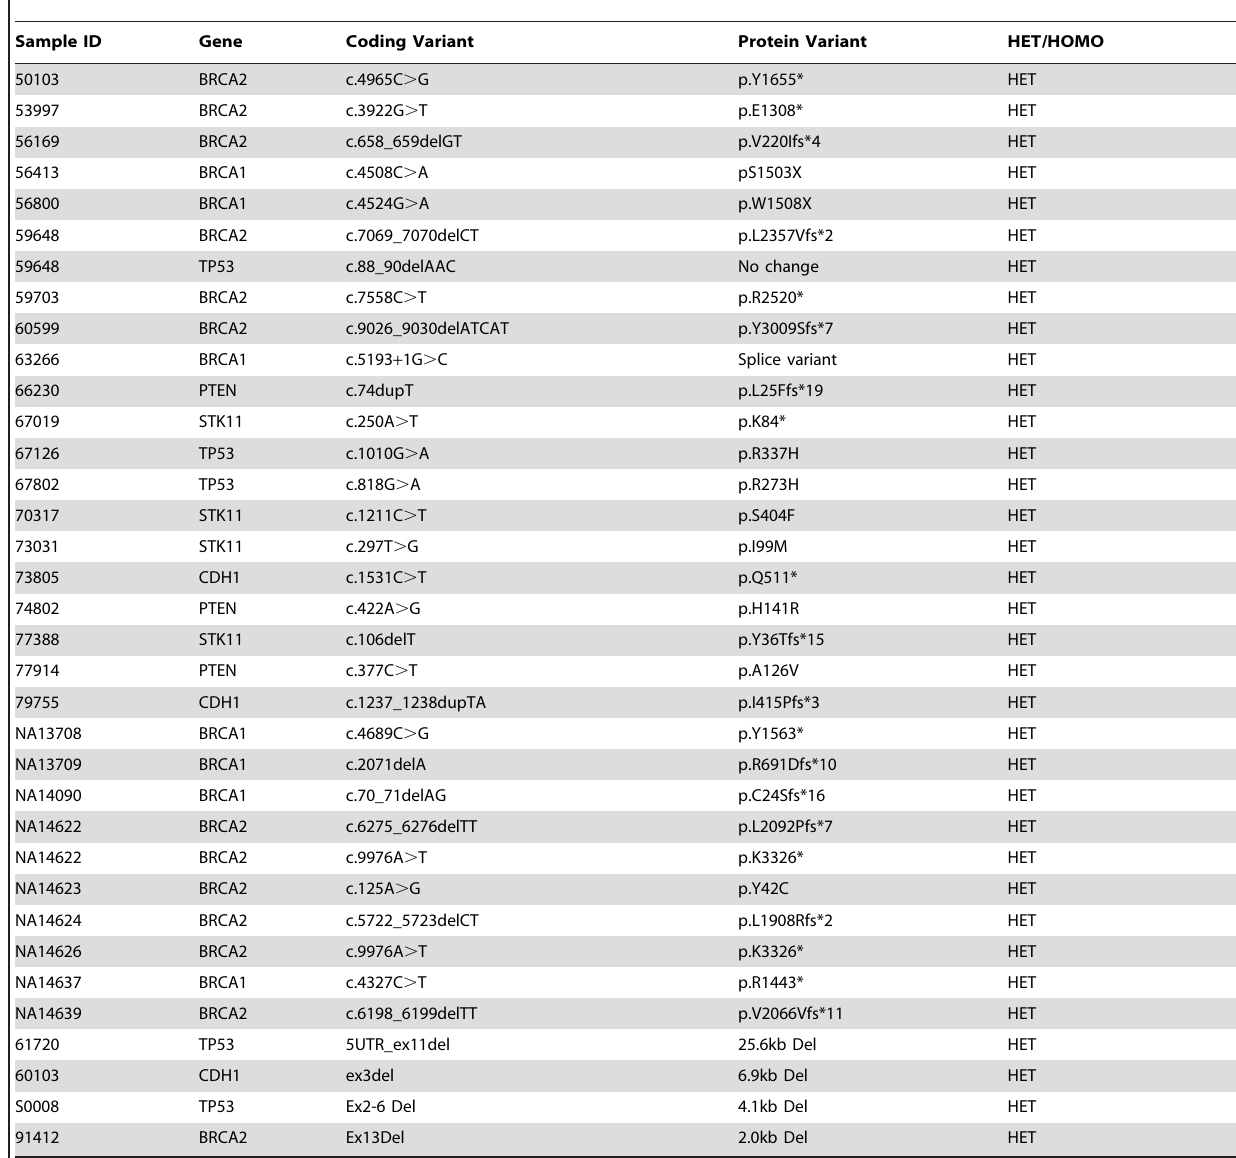
Table 2. Validation of BRCAplus deleterious variant detection on previously characterized samples.